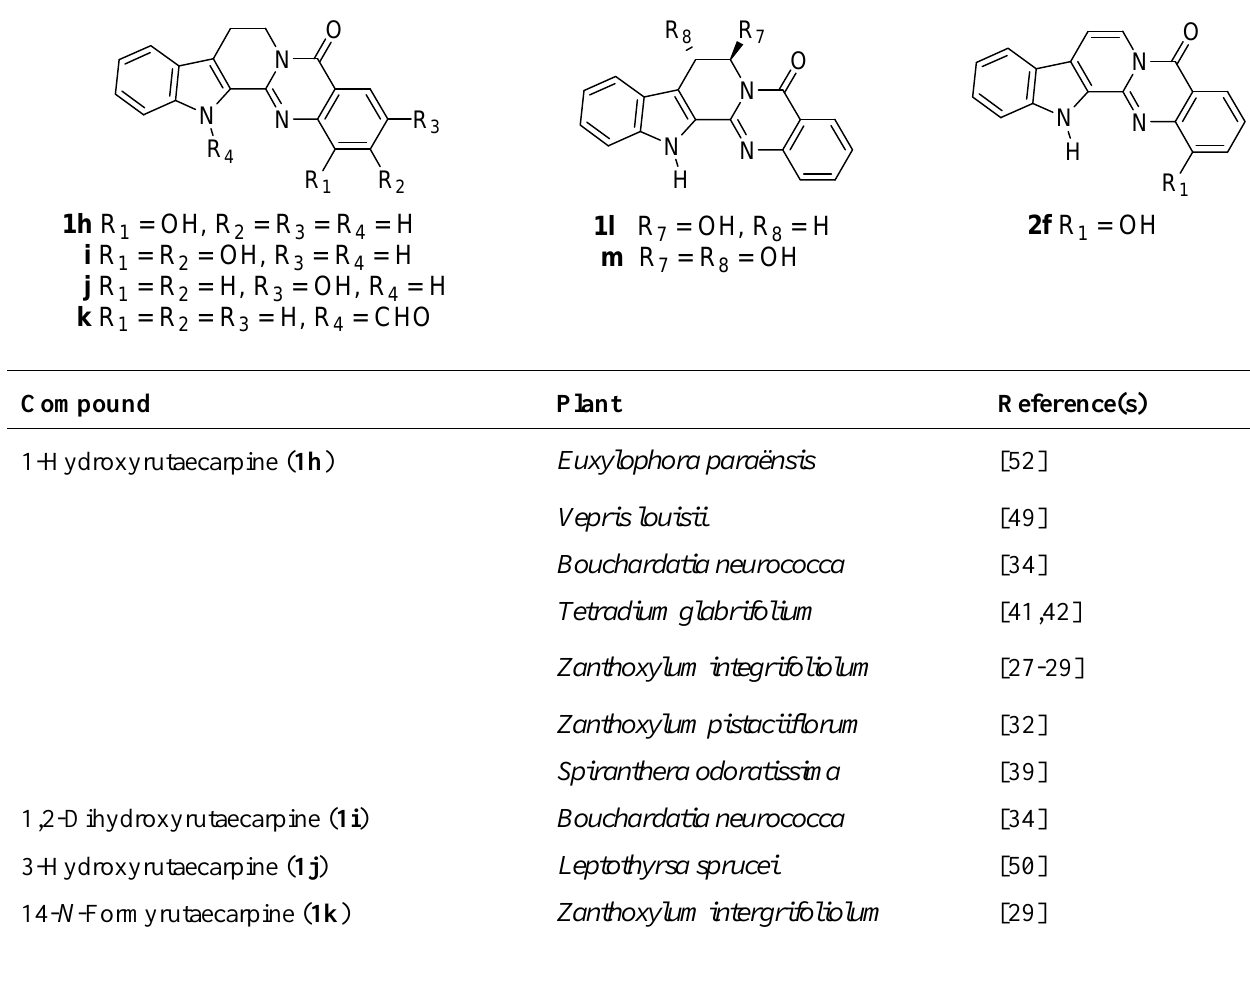
Table 4. Structure and Sources of